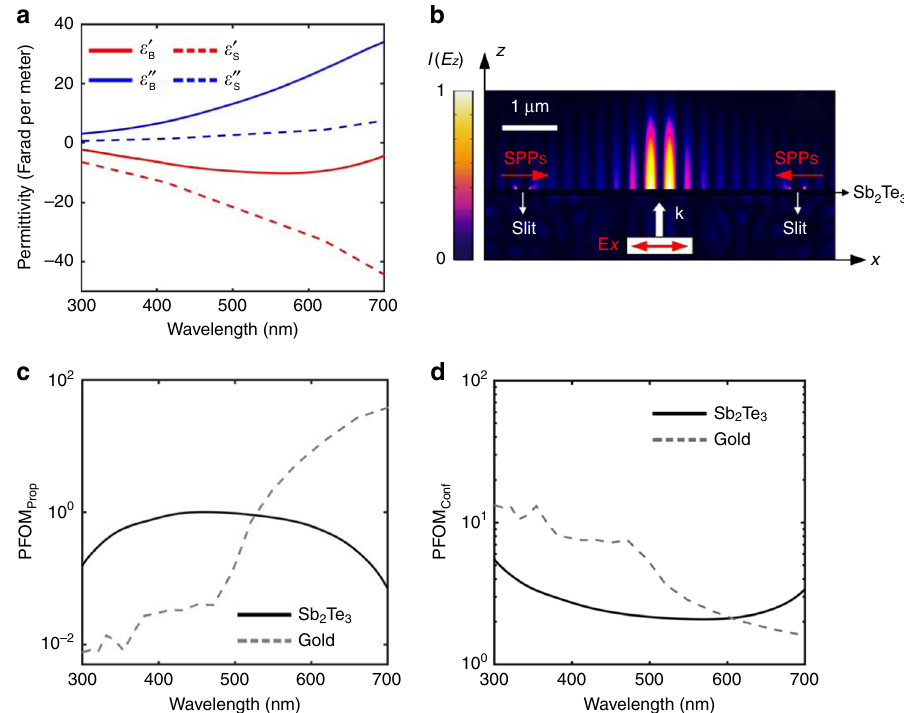
Fig. 2 Dispersion analysis and fi gure of merit of the topological insulator thin fi lm. a Real (red colour) and imaginary (blue colour) parts of the permittivity spectra of the bulk (solid curves) and surface (dashed curves) states of the Sb 2 Te 3 thin fi lm, respectively. The thickness of the bulk and the surface layer of Sb 2 Te 3 thin fi lm is 100 and 1.5 nm, respectively. b The numerically simulated normalized intensity distribution of the SPPs fi eld excited at the interface between the Sb 2 Te 3 thin fi lm and the air. The thickness of the Sb 2 Te 3 fi lm is 100 nm. The width of air slits is 250nm. The x -linearly polarized incident light has a wavelength of 640 nm. The period of the interference fringes of evanescent SPPs standing waves is 302 nm, which suggests the SPP wavelength of 604 nm in the numerical simulation. c , d Dependence of plasmonic fi gure of merit for propagation length ( c ) and degree of con fi nement ( d ) on the ultraviolet-visible wavelength for the Sb 2 Te 3 thin fi lm and the gold material,